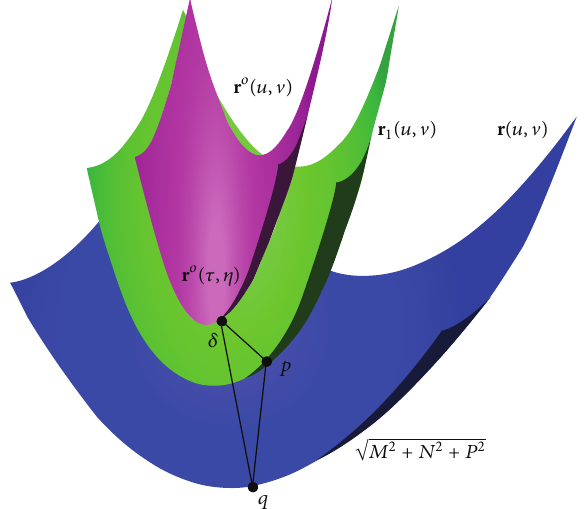
Figure 5: Topological property of the